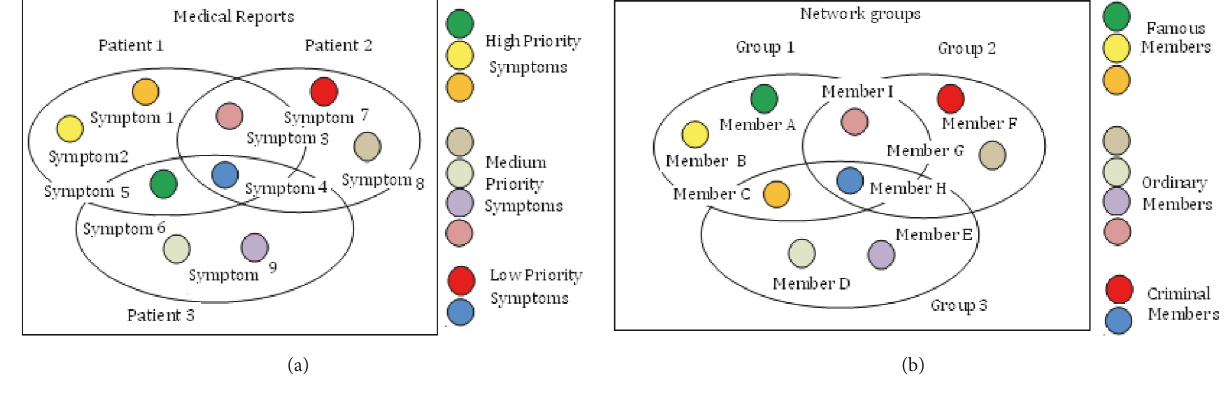
Figure 10: (a) Medical report processing. (b) Social network